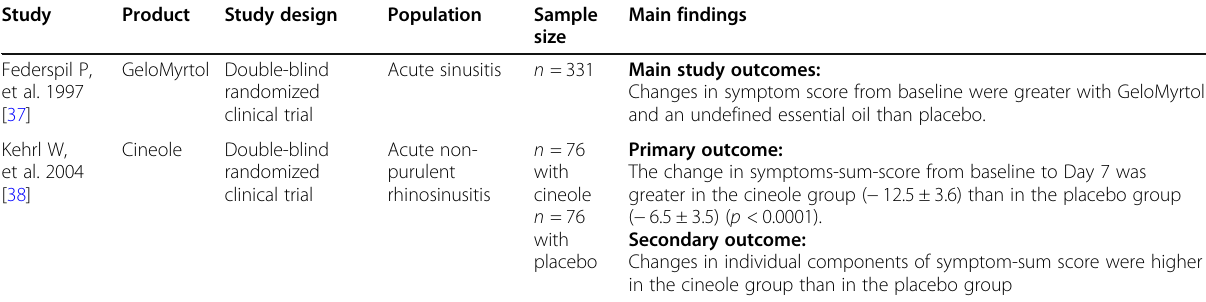
Table 4 Clinical studies of GeloMyrtol and cineole